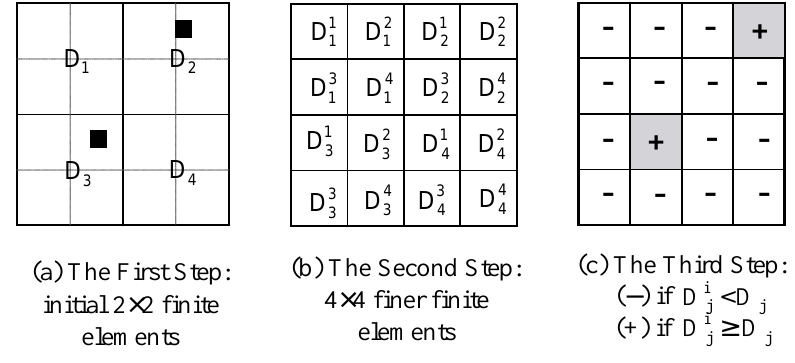
Fig. 1. The conceptual illustration of three-steps process: in (a), (cid:1) indicates local damages. 1 { ϕ ω ) } = − ([ L k ][ T ( ω )]) T [ k k ( ω )]([ L k ] (15) k ( ω 2 [ T ( ω )]) { A m ( ω ) } ( k = 1 , 2 , . . . , N